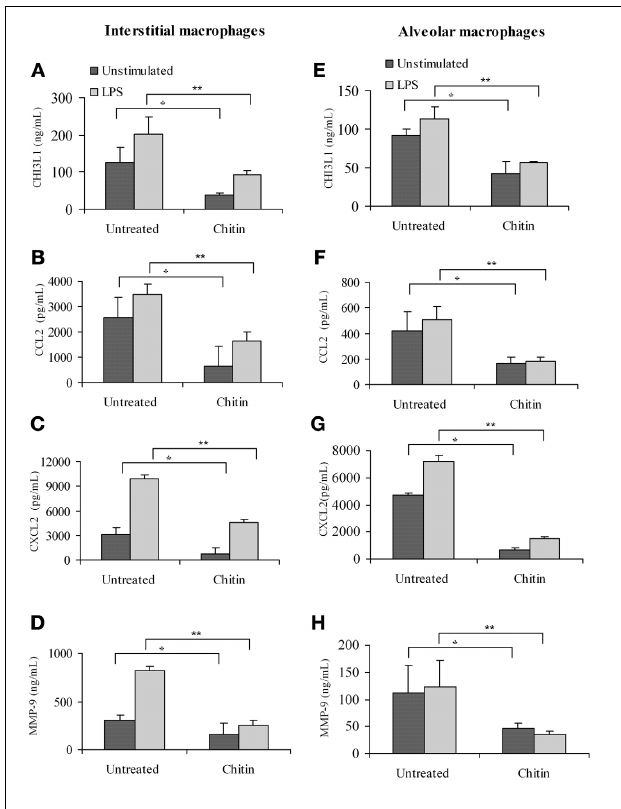
FIGURE 9 | In vivo treatment with chitin microparticles decreases CHI3L1, CCL2, CXCL2, and MMP-9 expression in pulmonary macrophages from 5 week mammary tumor bearers. Interstitial macrophages from untreated and chitin treated mice was analyzed for: (A) CHI3L1; (B) CCL2; (C) CXCL2; and (D) MMP-9 expression by ELISA, and alveolar macrophages from untreated and chitin treated mice was analyzed for: (E) CHI3L1; (F) CCL2; (G) CXCL2; and (H) MMP-9 expression by ELISA. For all experiments, N = 10/group; ∗ p ≤ 0 . 05; ∗∗ p ≤ 0 .